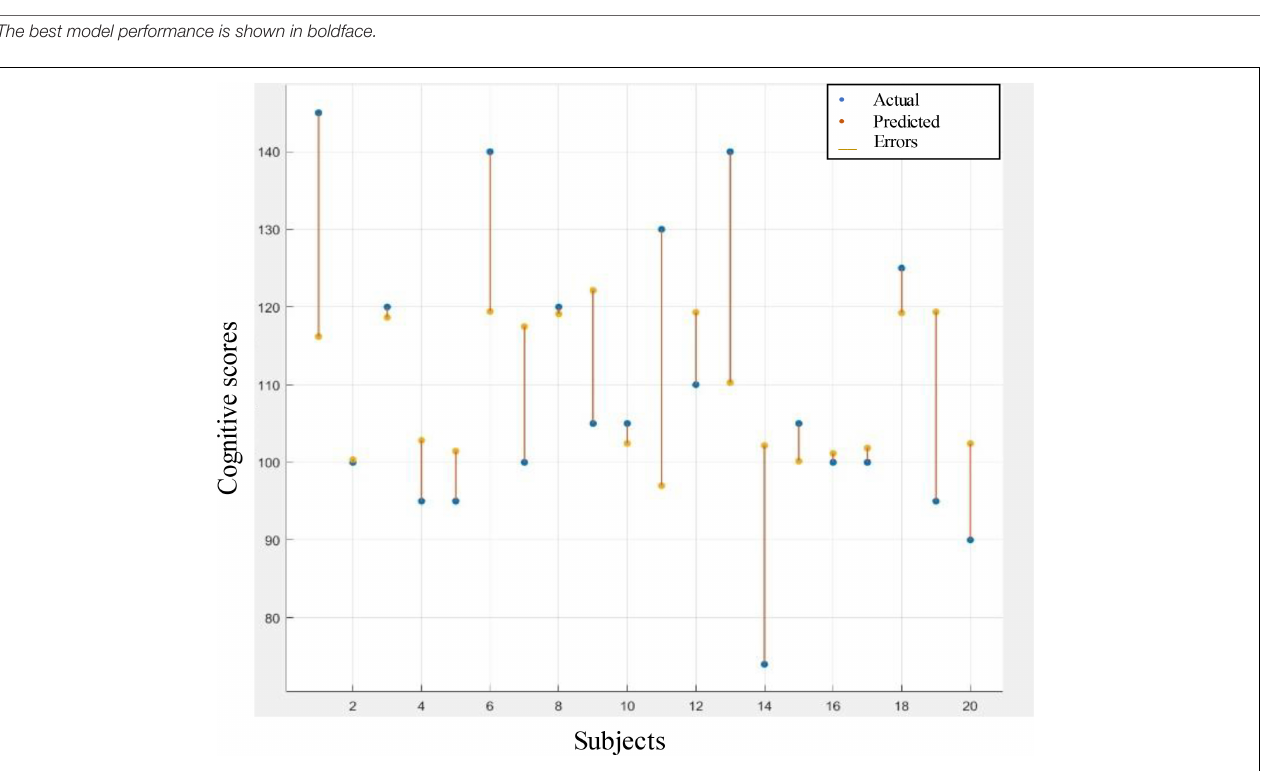
FIGURE 6 | Response plot of predicted cognitive scores versus the actual one. Regression based prediction using radius graph feature to predict the cognitive